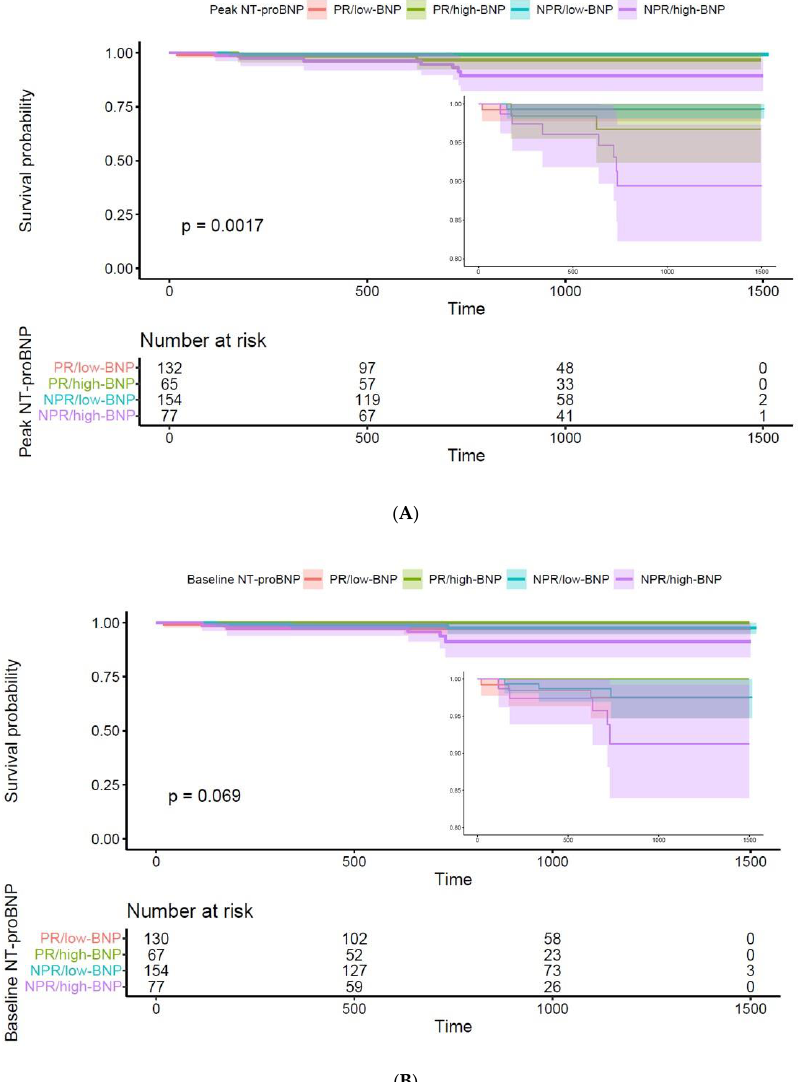
Figure 2. Kaplan–Meier curves for cumulative death combining peak or baseline value of NT-proBNP and plaque types. ( A ) Death for patients of four groups divided by plaque phenotype and peak NT-proBNP; ( B ) Death for patients of four groups divided by plaque phenotype and baseline NT-proBNP. PR, plaque rupture; NPR, non-plaque rupture. Then, subjects divided by the level of the peak value of NT-proBNP were compared in the subgroups of PR and NPR. In patients with PR, there was no significant difference